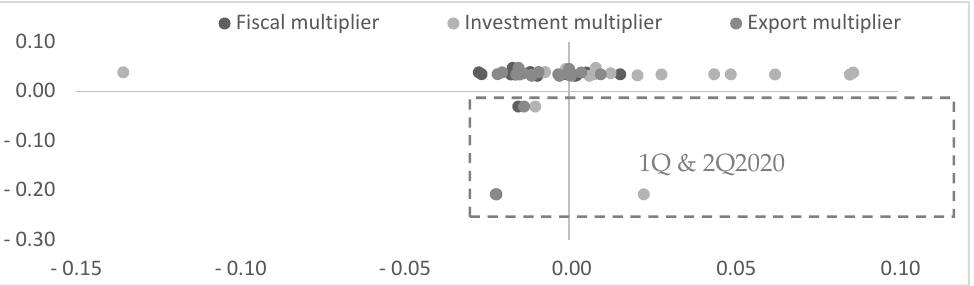
Figure 19. Correlation of changes in autonomous expenditure multipliers to GDP—Spain, own work, source: Eurostat.